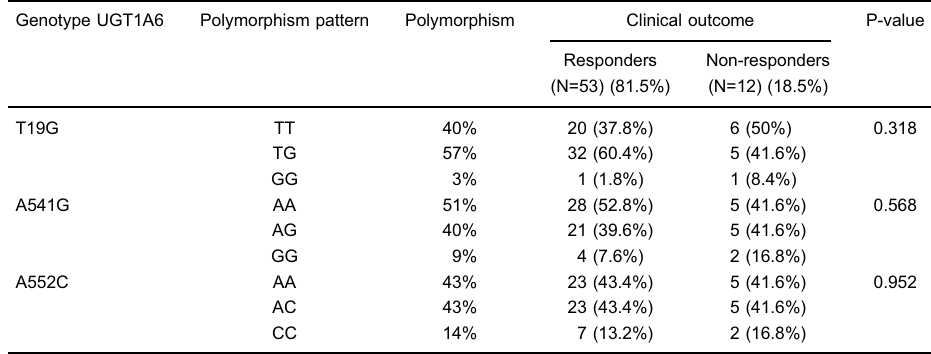
Table 2. Association of UGT1A6 gene polymorphisms with clinical outcome